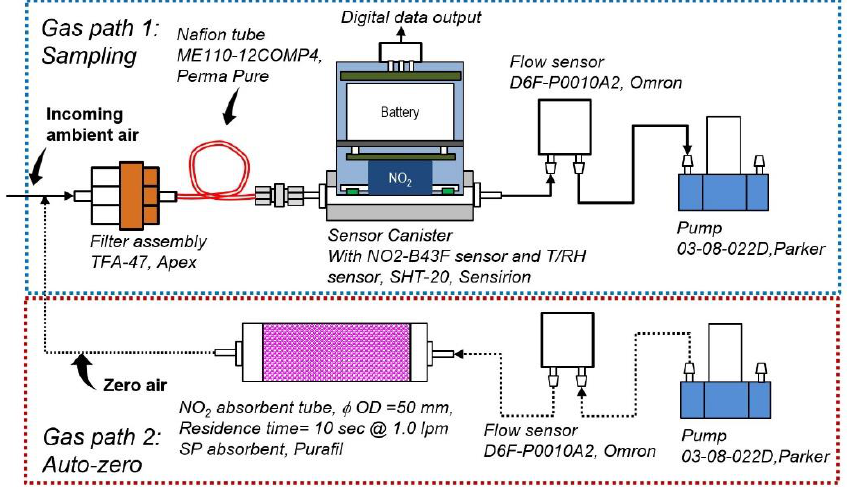
Figure 1. Schematic of the experimental setup.